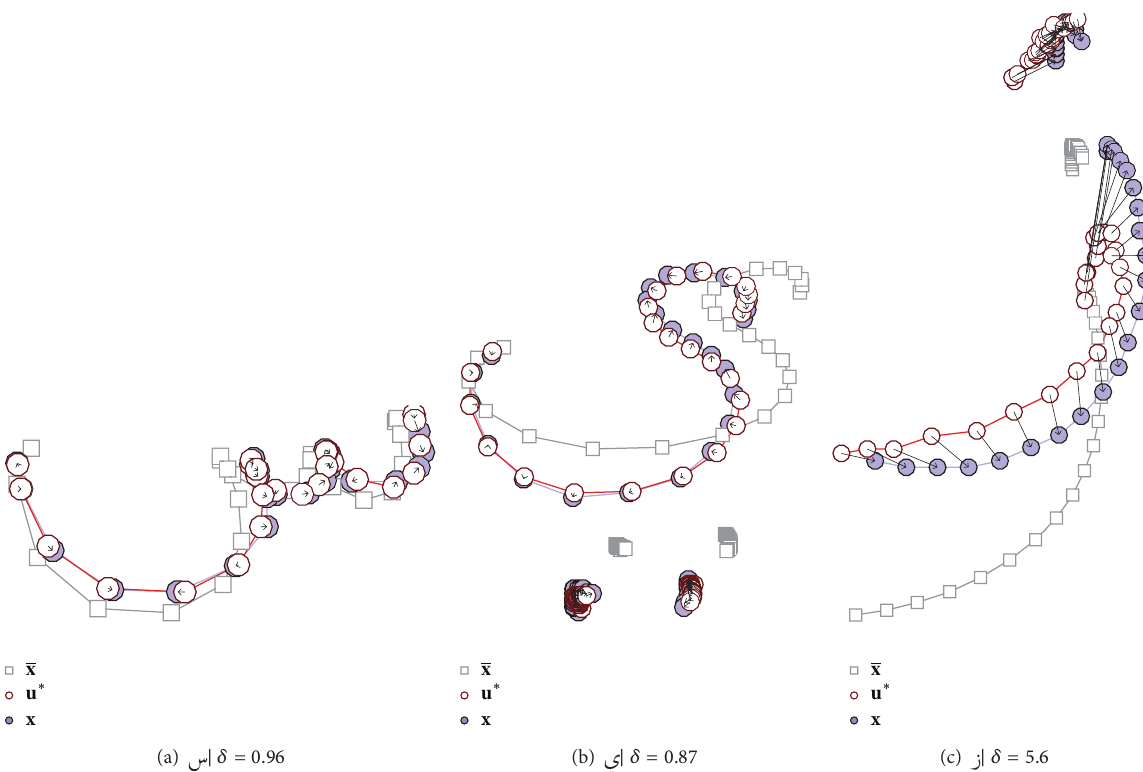
(cid:6) (cid:4) # H J H J B (cid:8) (cid:8) )